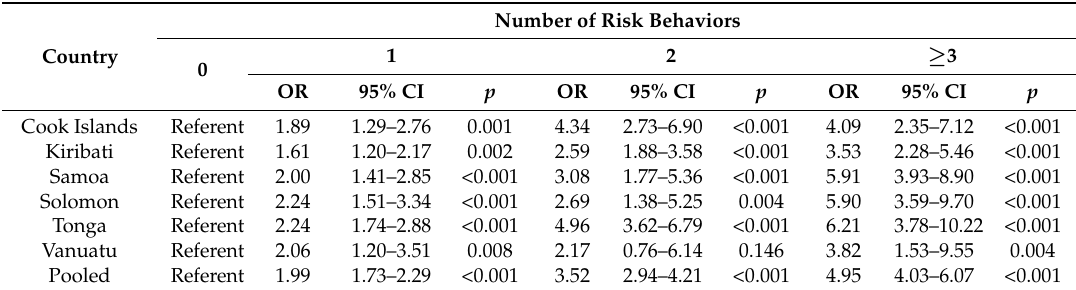
Number of Risk Behaviors